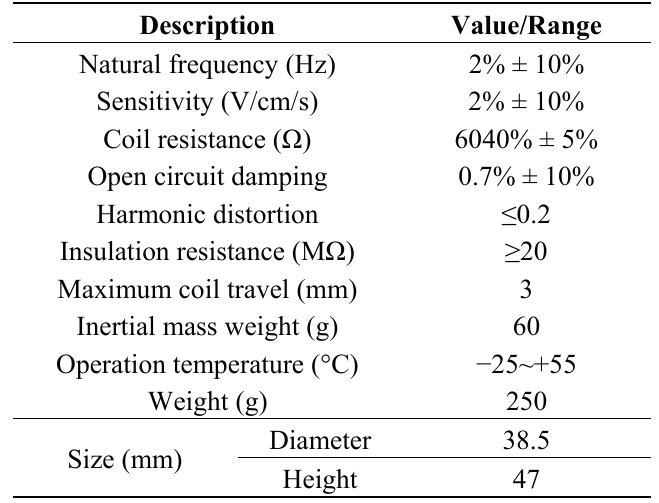
Figure 2. Amplitude and phase responses of the 2-Hz geophone. ( a ) amplitude response; ( b ) phase response. Table 1. Technical specifications of the selected 2-Hz geophone